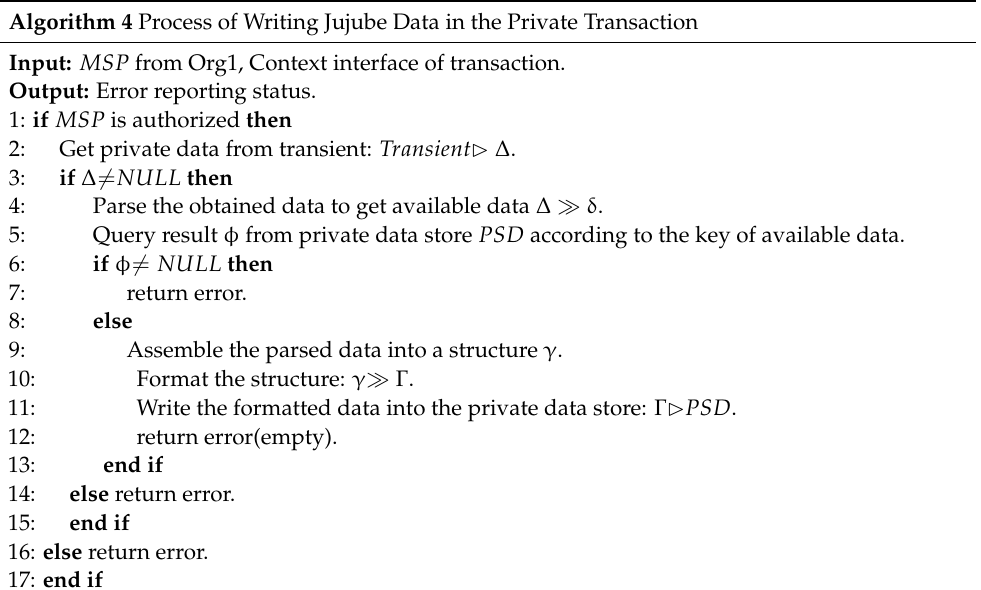
Algorithm 4 Process of Writing Jujube Data in the Private